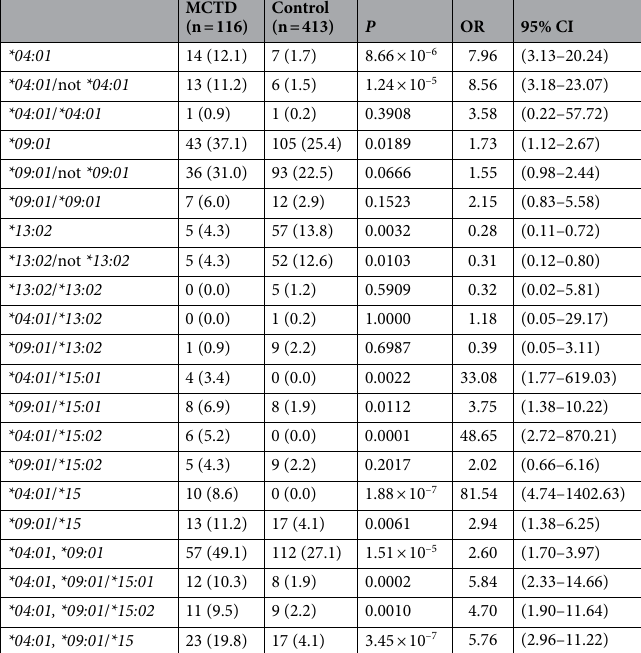
Table 3. HLA-DRB1 genotype frequency in MCTD patients and controls. Genotype frequencies are shown in parentheses (%). Association was tested by Fisher’s exact test, using 2 × 2 contingency tables. Genotype frequency is the frequency of individuals with a specific genotype in some populations. Genotype frequency of the heterozygous genotype of DRB1*04:01 is shown in the row “ *04:01/ not *04:01 ” and that of the homozygous genotype of DRB1*04:01 is shown in the row “ *04:01/*04:01 ”. MCTD: mixed connective tissue disease; OR: odds ratio; CI: confidence